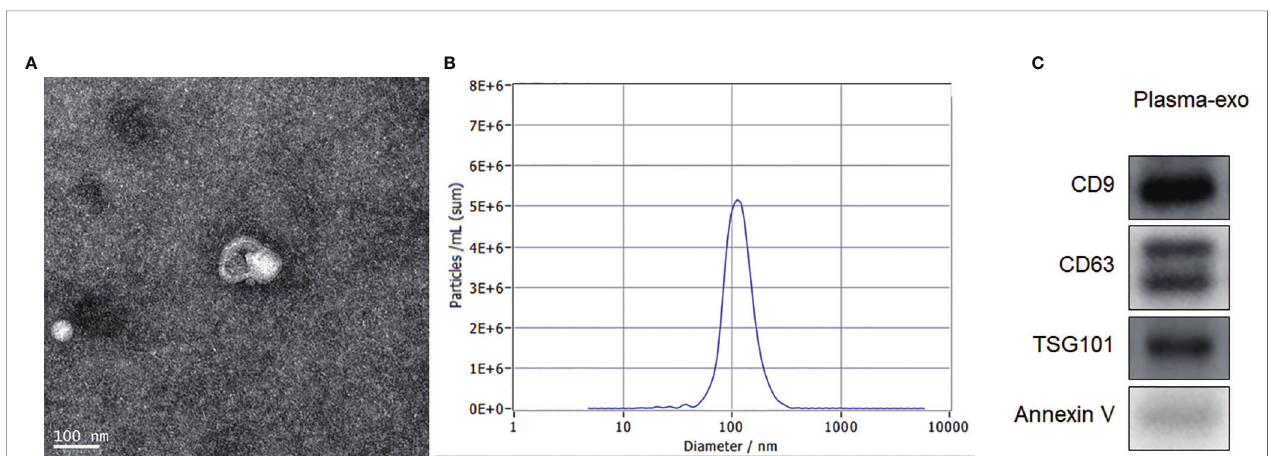
FIGURE 1 | Exosome characterization. (A) TEM images showed that the exosomes were clustered and connected with each other, with clear background. The diameter was between 100 nm and 200 nm. The shape was double disc like vesicle structure with intact lipid capsule; (B) NTA data revealed that the median value of the total particles was about 100 nm, mainly distributed between 50 and 200nm, and the diameter of a small number of particles was between 0-50 nm; (C) Western blotting showed that patient plasma exosomes were positive for the four exosomal markers, Annexin V, Tsg101, CD9 and